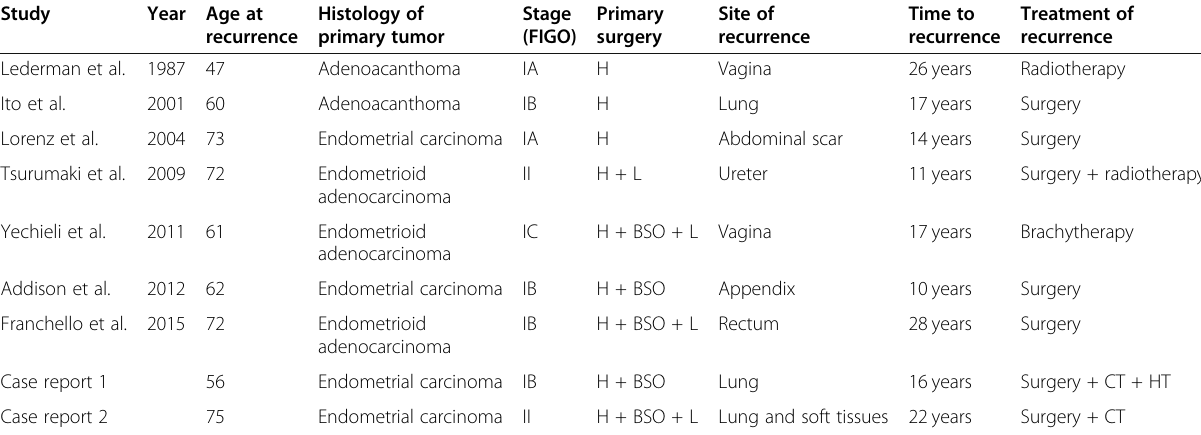
Table 1 Cases of late recurrence of endometrial carcinoma reported in literature